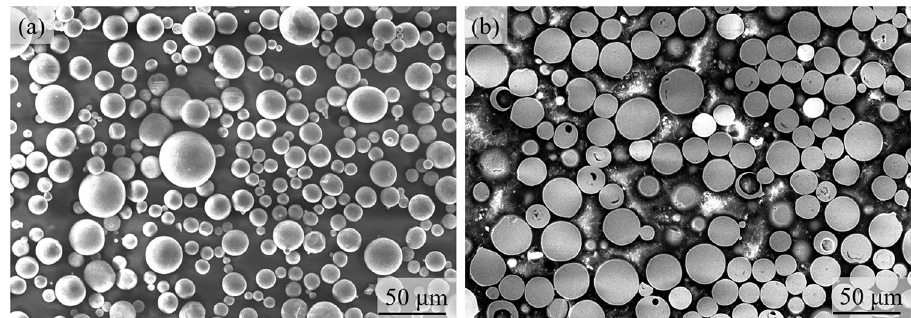
Fig. 6 SEM images of a appear- ance and b cross-section of the optimized